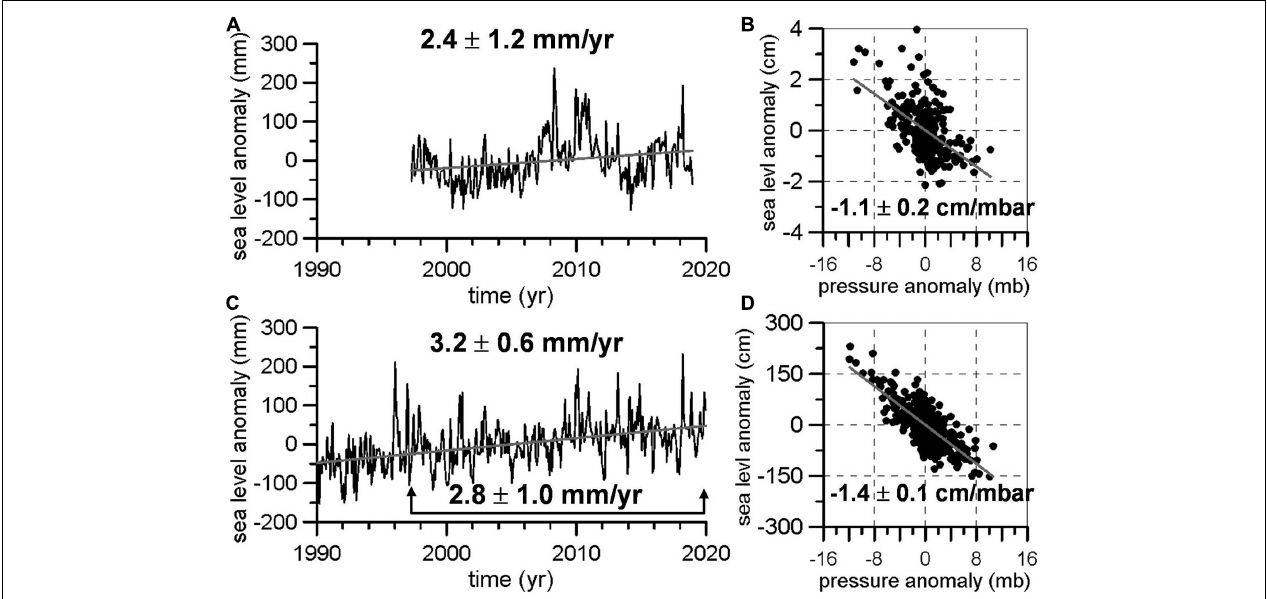
FIGURE 8 | (A) Time series of residuals or anomalies of sea level at the Palma de Mallorca tide gauge. (B) Linear regression of sea level residuals on atmospheric pressure at the Balearic Channels. The linear trend for the sea level time series and the slope for the regression are included. (C) Time series of sea level residuals at the L’Estartit tide gauge. Linear trends for the complete period, and the 1996–2019 period, are included. (D) Linear regression of sea level on atmospheric pressure at the Northern Sector.